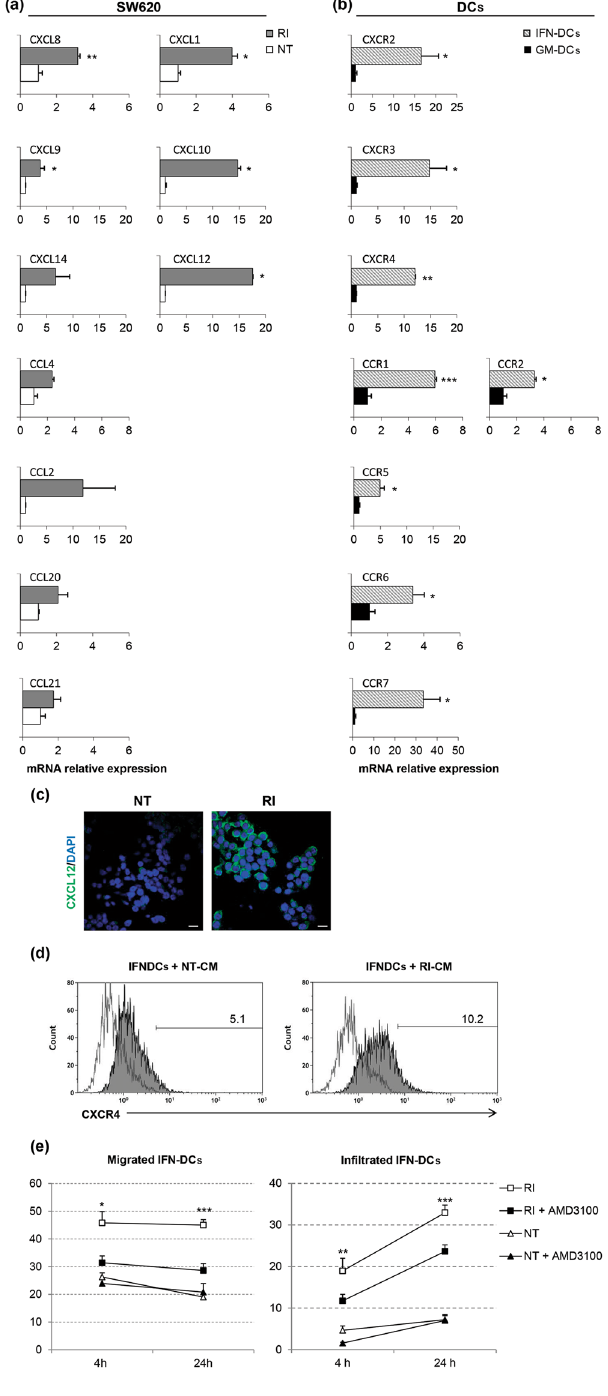
Figure 6. The CXCR4/CXCL12 axis drives the migration of IFN-DCs toward RI-treated SW620 cells. Analysis of the expression of CC-/CXC-chemokines in SW620 cells ( a ) and of relative chemokine receptors in IFN-DCs ( b ) by qPCR. Expression values in the RI-treated SW620 cells and in the IFN-DCs are relative to the NT SW620 cells and to the GM-DCs, respectively (means ± s.e.m., * P ≤ 0.05, ** ≤ 0.01, *** ≤ 0.001). ( c ) Immunofluorescence analysis of CXCL12 expression on both NT and RI-treated SW620. Images were collected with the same acquisition parameters. Scale bar, 20 µ m. ( d ) Analysis of CXCR4 expression by flow cytometry on IFN-DCs after exposure to CM from 48 and 72 h NT and RI-treated SW620 cells (N = 3). ( e ) IFN-DC migration toward RI-treated SW620 cells is significantly inhibited by the CXCR4 inhibitor, AMD3100. Migration in the presence or absence of AMD3100 were performed in microfluidic devices, and the acquired images were quantified at 4 and 24 h (magnification 4 × ). Means ± s.e.m. are shown ( * P ≤ 0.05, ** ≤ 0.01, *** ≤ 0.001, Student’s t-test) (N = 3 experiments; a means of 10 images for group were